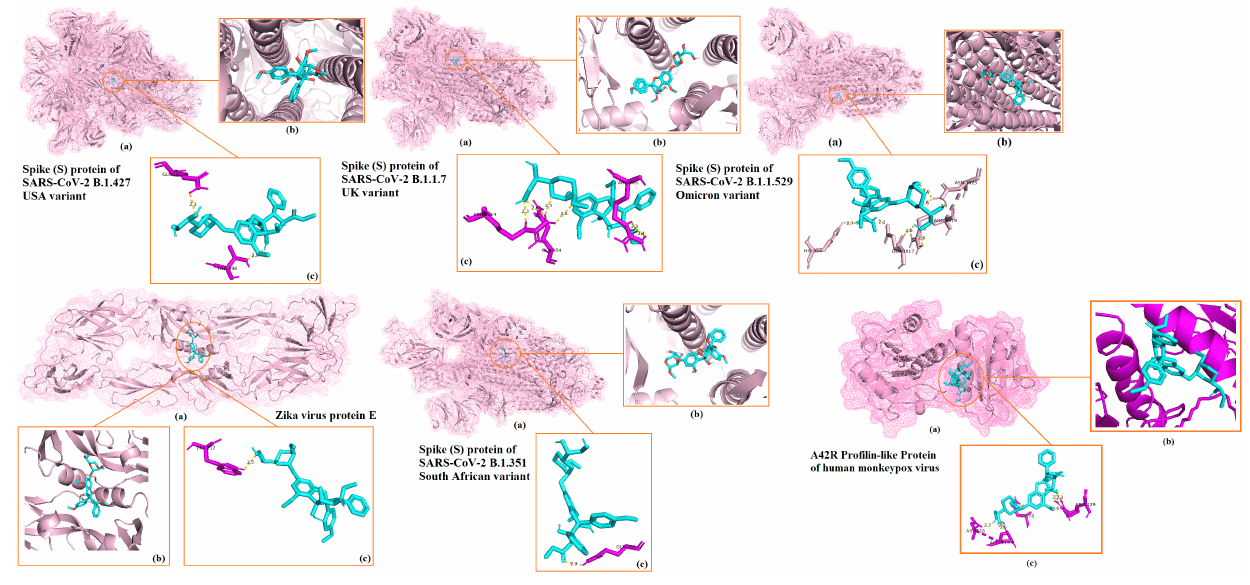
Figure 2. Results of the docking analysis showing the 6 main binding sites of silvestrol with the different viral surface proteins. The molecular interactions in the 3D structures were visualized in PyMOL. ( a ) Indicates binding domain. ( b ) Binding site. ( c ) Interacting amino acids of receptor (purple) and ligand (blue).